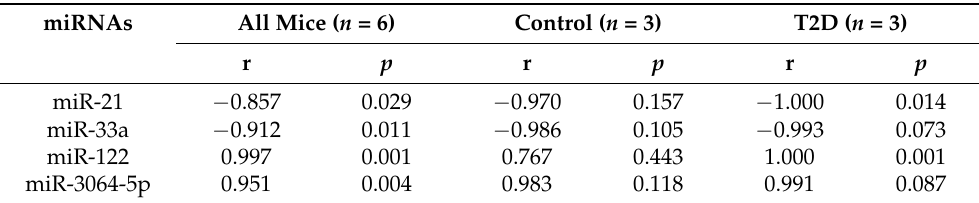
Table 2. The Pearson correlation between circulating miRNAs levels and aortic lesion areas in the ApoE-/- mice with streptozocin (STZ)-induced type 2 diabetes (T2D). miRNAs All Mice ( n = 6) Control ( n = 3) T2D ( n = 3)